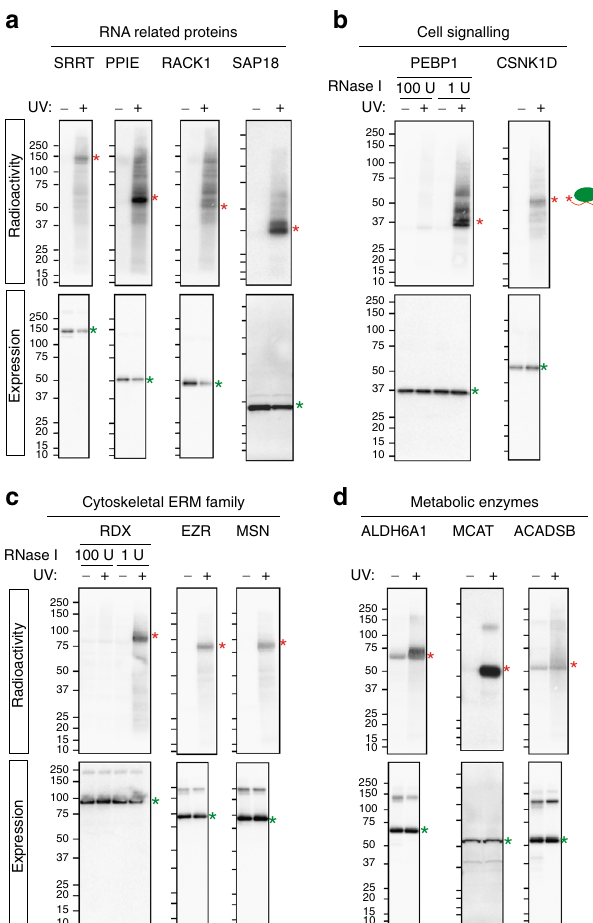
Fig. 6 Validation of RBPs using PNK assay. Brie fl y, 3Flag-HBH-tagged proteins are stably expressed in Flp-In T-Rex 293 cells. The proteins are af fi nity puri fi ed from UV crosslinked and non-crosslinked cells under denaturing conditions. RNA bound to proteins is labelled with radioactive 32 P using the PNK enzyme. The RNA – protein heteroconjugates are separated by size (SDS-PAGE) and transferred to a membrane on which the RNA binding capacity is detected by autoradiography (RNA band labelled with red asterisk). The proteins are detected by western blot (bottom) using anti-Flag antibody (protein band labelled with green asterisk). The assay was performed on the following class of proteins: a RNA-related proteins comprising the classical RRM domain-containing RBPs serrate RNA effector molecule (SRRT) and peptidylprolyl isomerase E (PPIE), as well as WD40 domain-containing protein receptor for activated C kinase 1 (RACK1) and splicing related protein Sin3A-associated protein 18 (SAP18). b Cell signalling proteins phosphatidylethanolamine binding protein 1 (PEBP1) and casein kinase 1 delta (CSNK1D). For PEBP1 an additional control with high amounts of RNase I treatment (100 units) is included alongside the standard (1 unit) treatment employed in all experiments. c Cytoskeleton ERM family proteins Radixin (RDX), Ezrin (EZR) and Moesin (MSN). An additional control with high amounts of RNase I is included for RDX. d Metabolic enzymes aldehyde